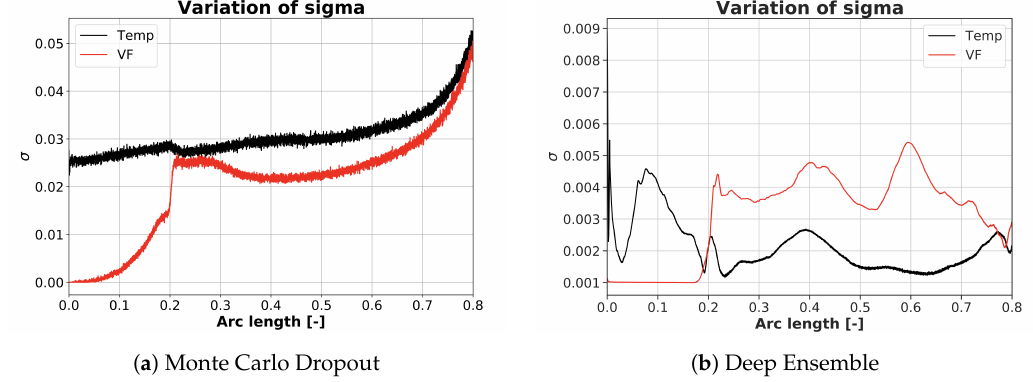
Figure A10. Extrapolation dataset: q (cid:48)(cid:48) = 14,000 W/m 2 , u = 0.05 ms − 1 . It is again seen that the σ of the DE model is one order of magnitude lesser compared to that of the MC Dropout model. This implies that the DE model is less uncertain about its predicted value and is more robust in